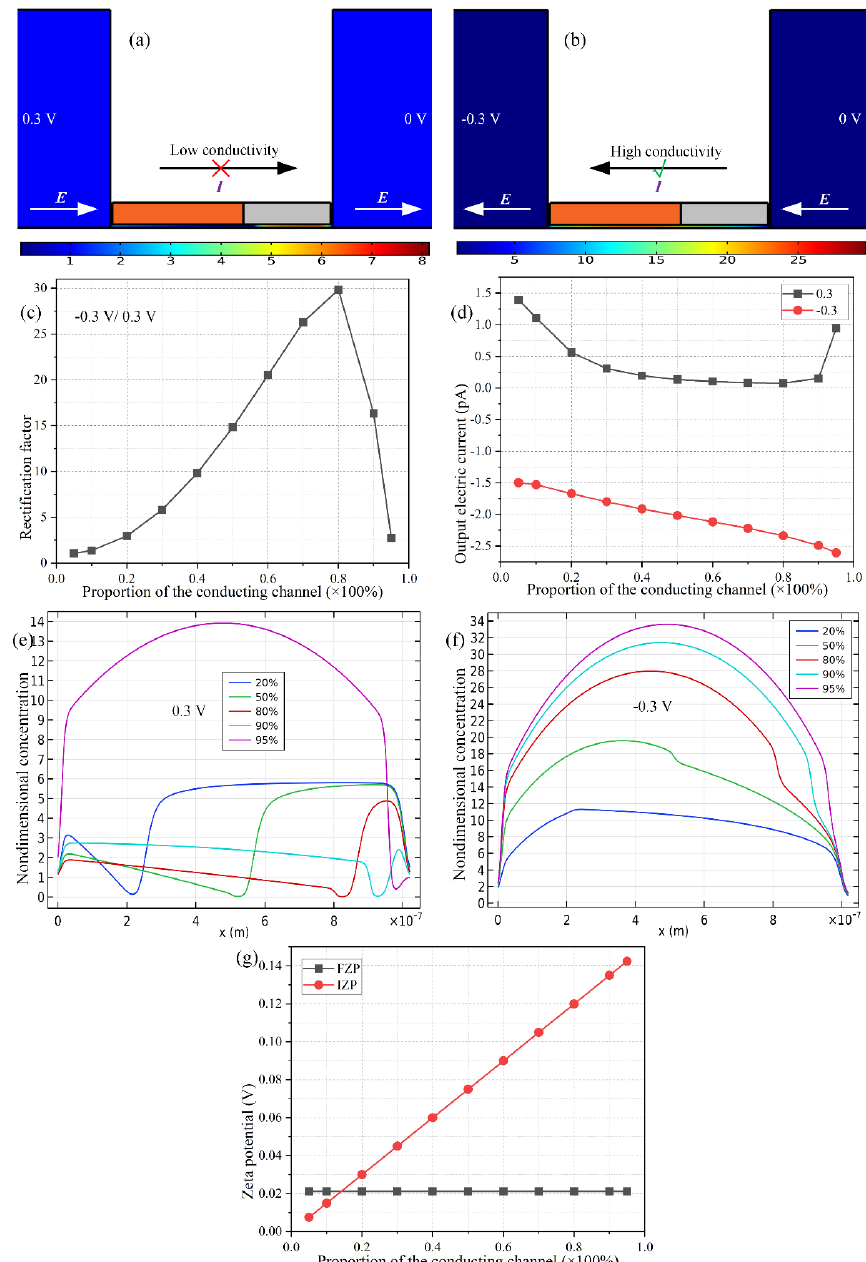
Figure 4. Influence of the length of the metallic nanopore with respect to that of the nanopore on the resulting rectification performance of the asymmetric metal-dielectric Janus nanopore, under a given parametric space of c 0 = 0.1 mM, Rn = 15 nm, V S = ± 0.3 V, and σ free = −0.001 C/m 2 . ( a ) A surface plot of the nondimensional electrolyte concentration for the “off” working state, in which the forward electric current diminishes due to the IDZ formed at the bipolar junction between the metallic and dielectric wall. ( b ) A surface plot of the nondimensional electrolyte concentration for the “on” working state, in which the backward electric current is magnified due to the IEZ formed at another bipolar junction at the central portion of the metallic nanopore. ( c ) Rectification factor and ( d ) the forward and backward output electric current as a function of the length proportion of the metallic channel. ( e ) Ion concentration distribution along the centerline of the Janus nanopore for a positive DC bias, and ( f ) that for a negative DC bias. ( g ) A comparison of fixed zeta potential (FZP) within the charged dielectric nanochannel and induced zeta potential (IZP) within the metallic nanochannel as a function of the length proportion of the conducting nanopore.